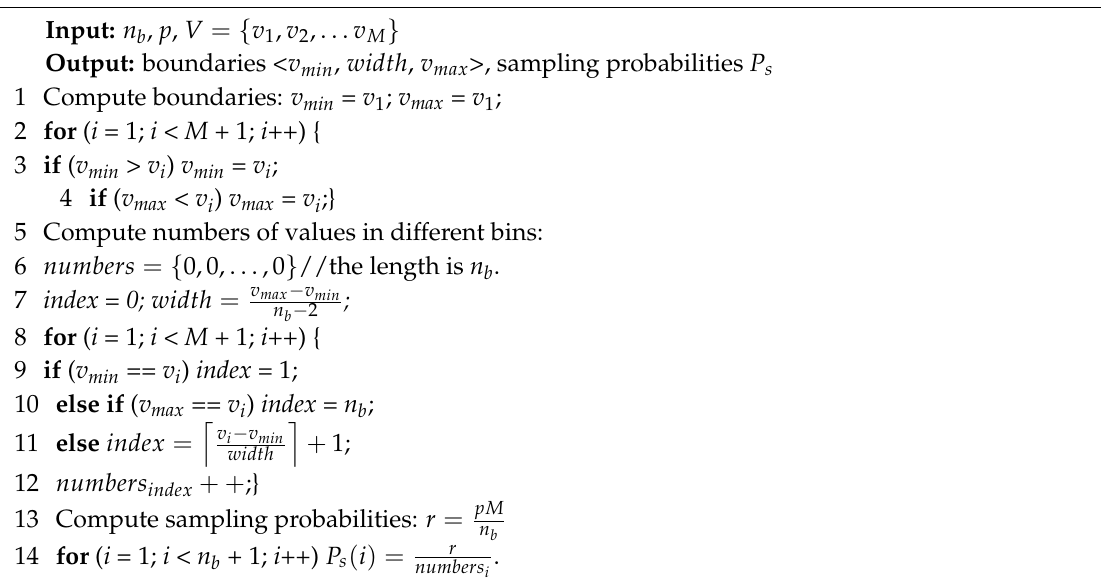
Algorithm 1: Adaptive Sampling Probability algorithm